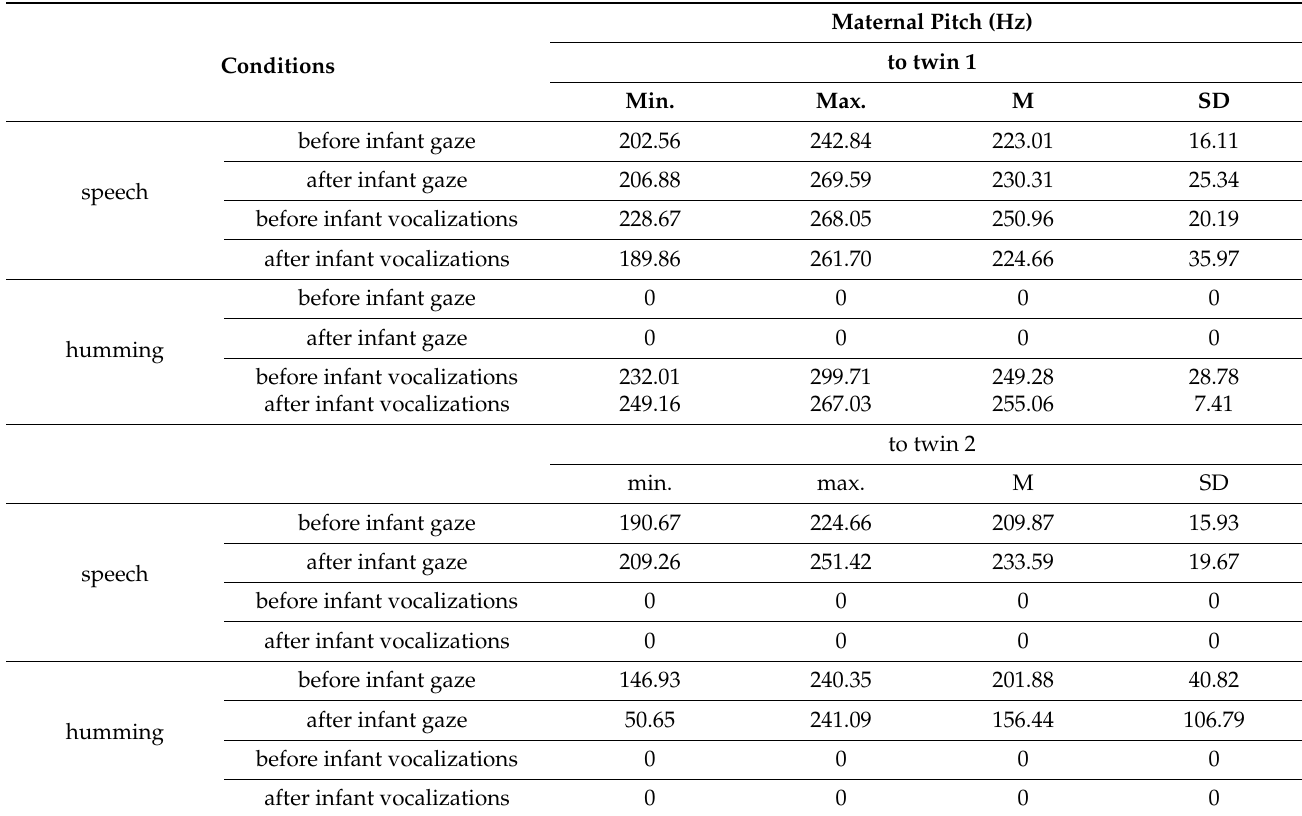
Table 3. Descriptive analysis of maternal pitch (Hz), in speech and in humming, before and after infant’s behavior.